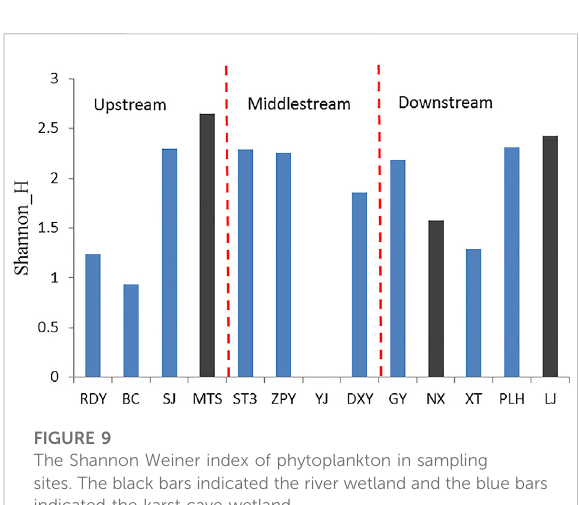
FIGURE 9 The Shannon Weiner index of phytoplankton in sampling sites. The black bars indicated the river wetland and the blue bars indicated the karst cave